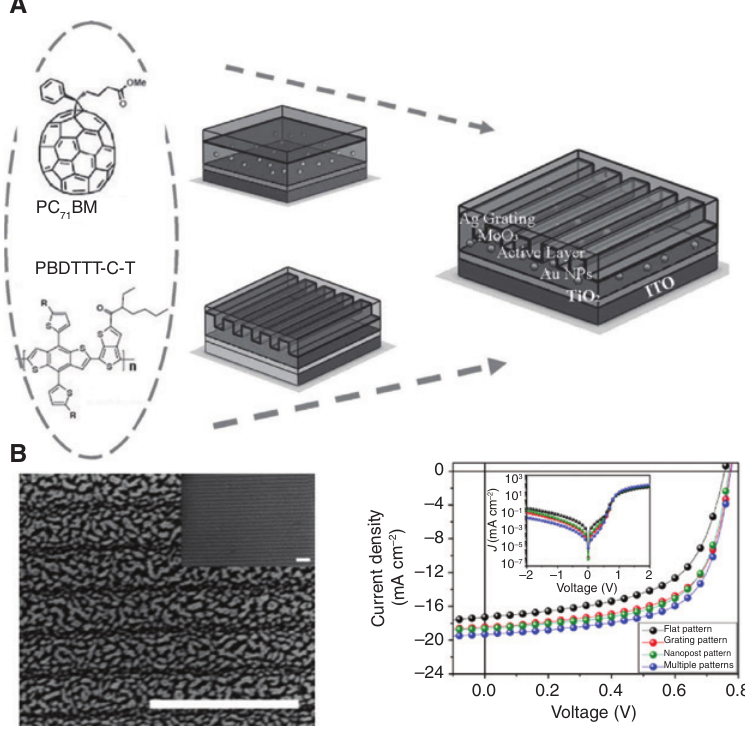
Figure 9: Dual plasmonic effects enhances light absorption. (A) Schematic illustration of inverted OPV construction with dual plasmonic structures, and the chemical structures of PBDTTT-C-T